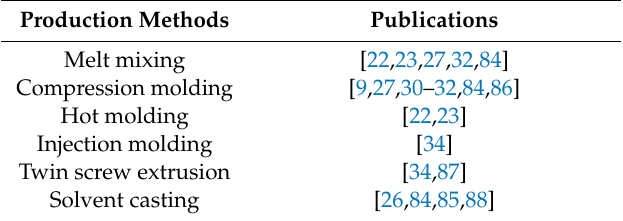
Table 9. Summary of production methods to produce microalgae-polymer blend